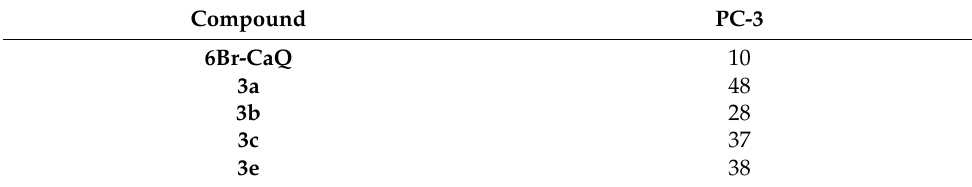
Table 2. GI 50 ( µ M) values for anti-proliferative effects of selected compounds 3a–e [a]. Compound PC-3